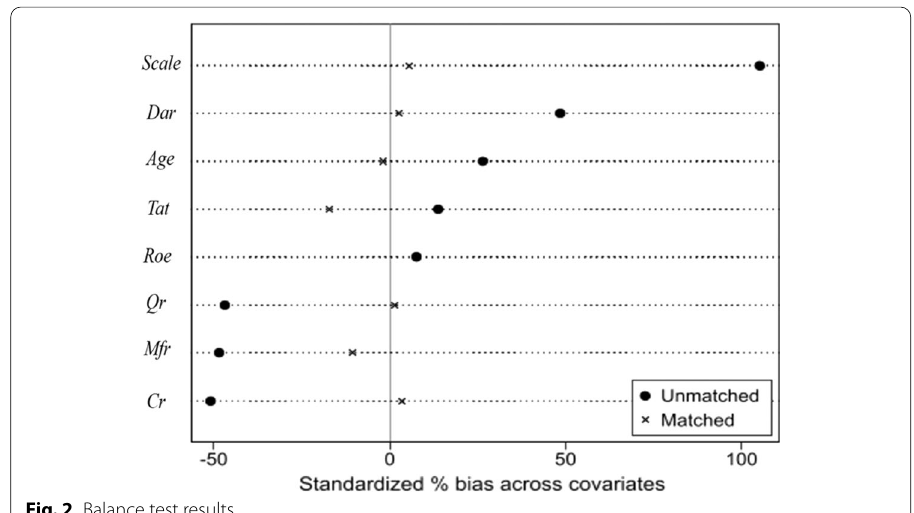
Fig. 2 Balance test